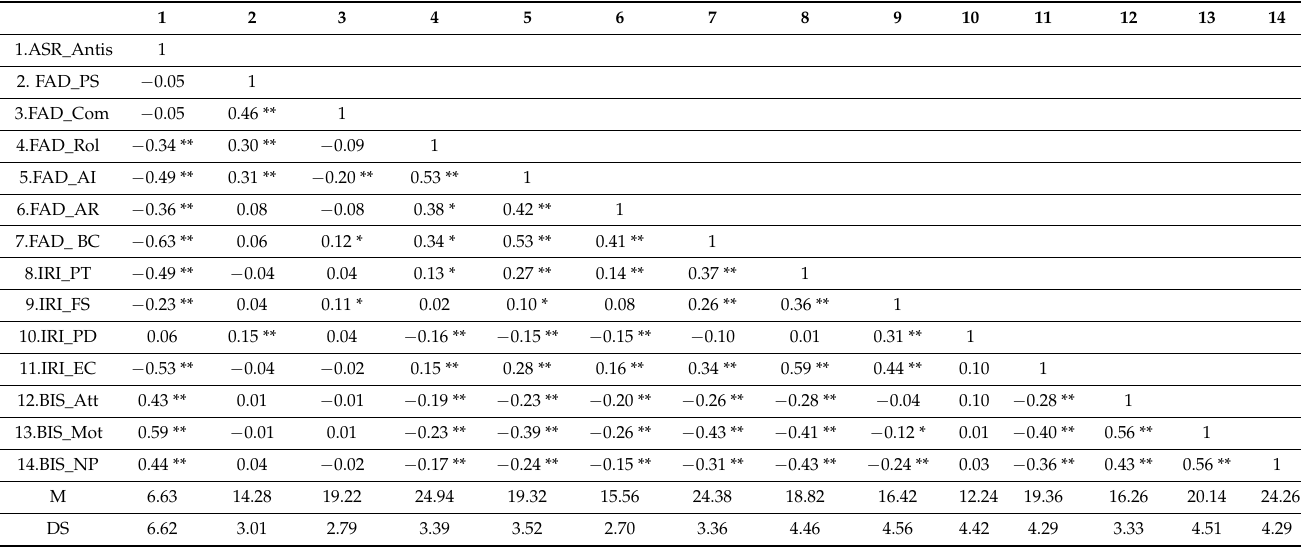
Table 2. Descriptive statistics and Pearson correlation coefficients between the starting theoretical model